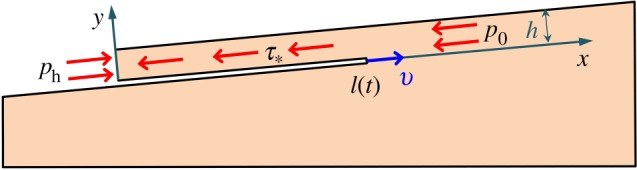
Dynamic version of the Palmer & Rice's [1] model for a slip surface in open-cut slope.